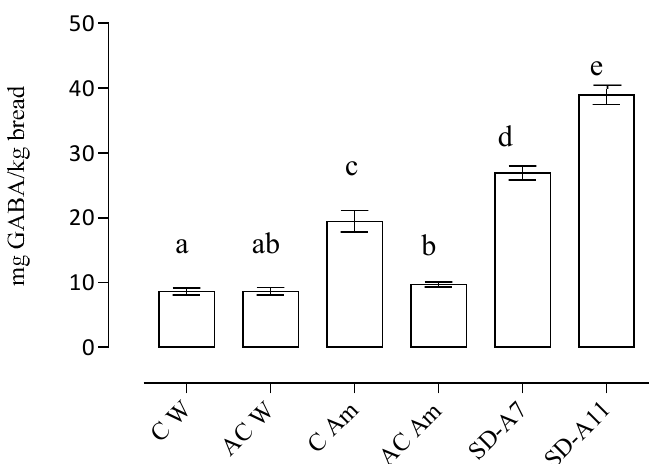
Figure 4. GABA concentration (mg / kg) in the breads (data are expressed as mean ± standard